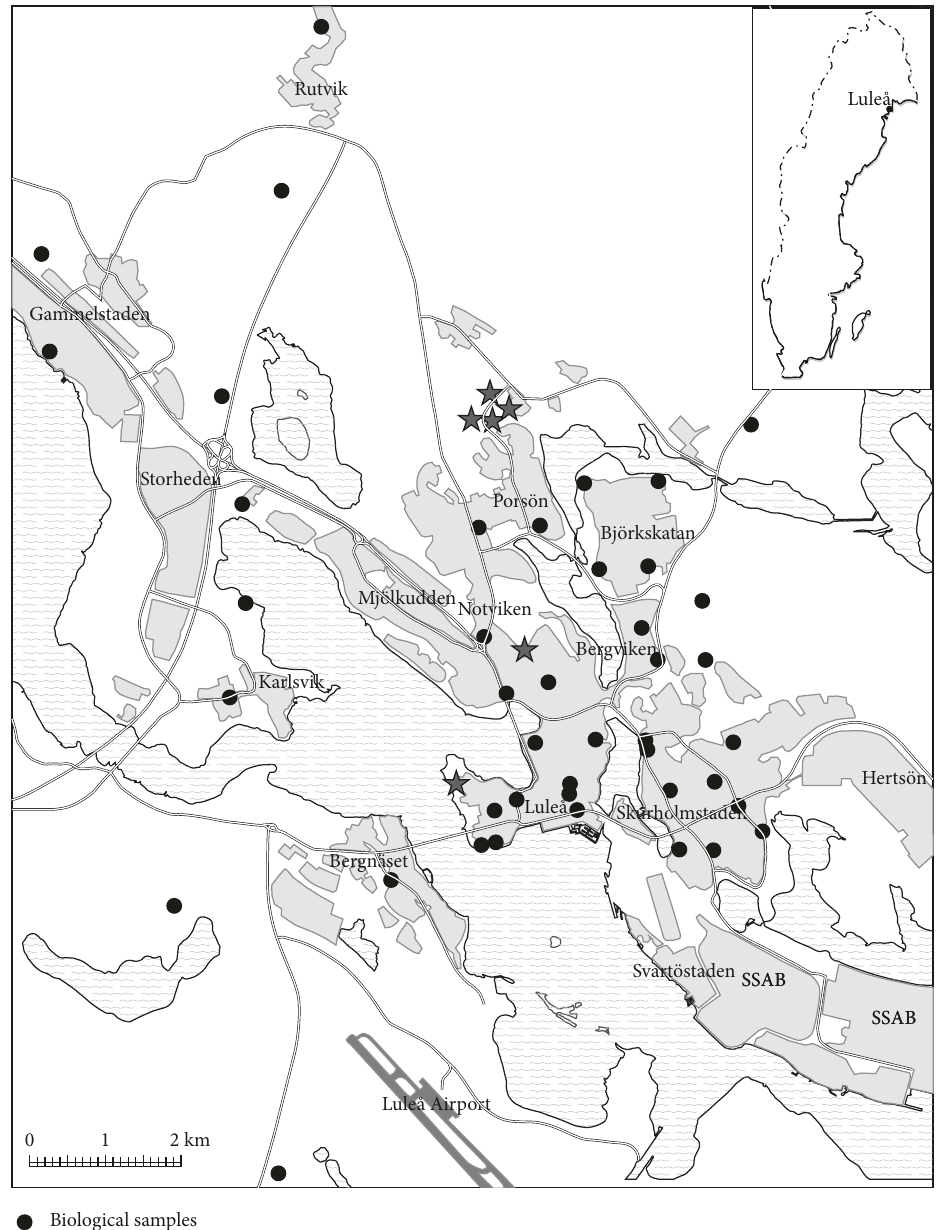
Figure 1: Map of the sampling locations. Filled circles represent the sampling point where biological samples have been collected (leaves, needles, and mushrooms); filled stars represent the locations where soil samples have been